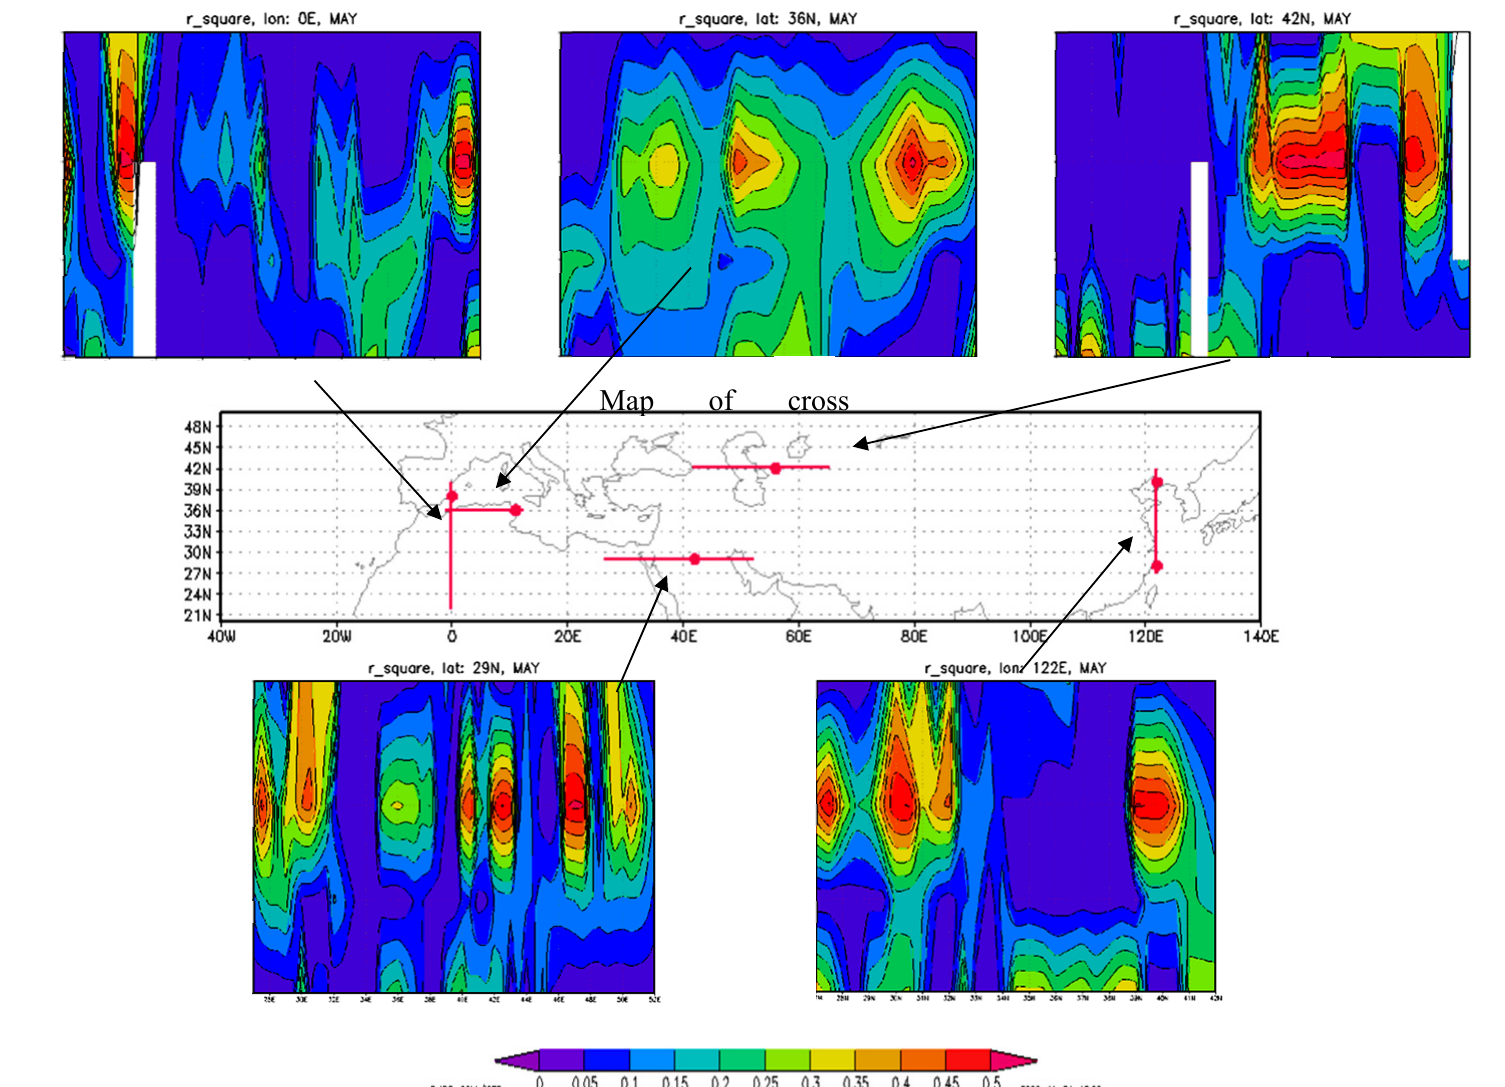
values with zooming on May. All values are significant at the p < 0.05 4 × 4 values that are insignificant. 4 × 4